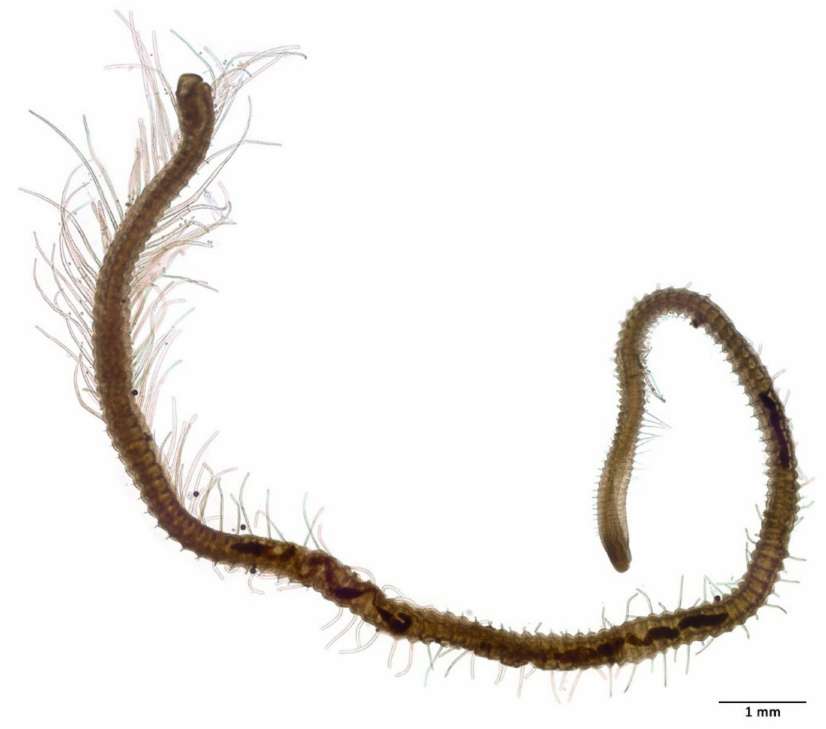
Figure 6. Branchiodrilus sp. (Naidinae, Naididae), a branchiate oligochaete showing external gills supported internally with hair chaetae (illustrated specimen from Cambodia). Photograph: P.